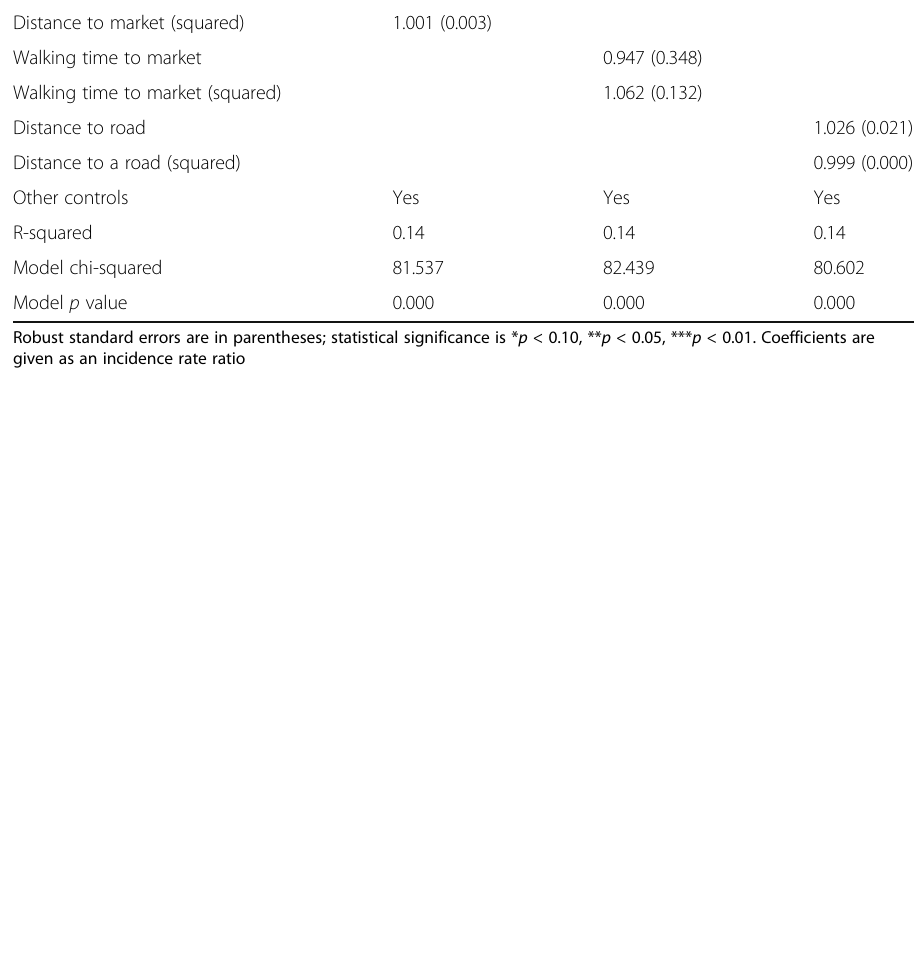
Table 8 Association between market access and food security: HFIAS scores for 324 smallholder households (1) (2) (3) Model Model